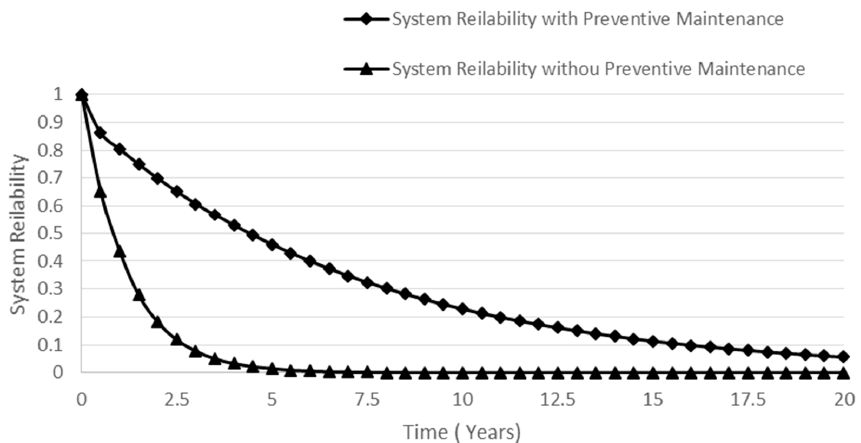
Figure 5. Unloading system reliability before and after preventive maintenance.